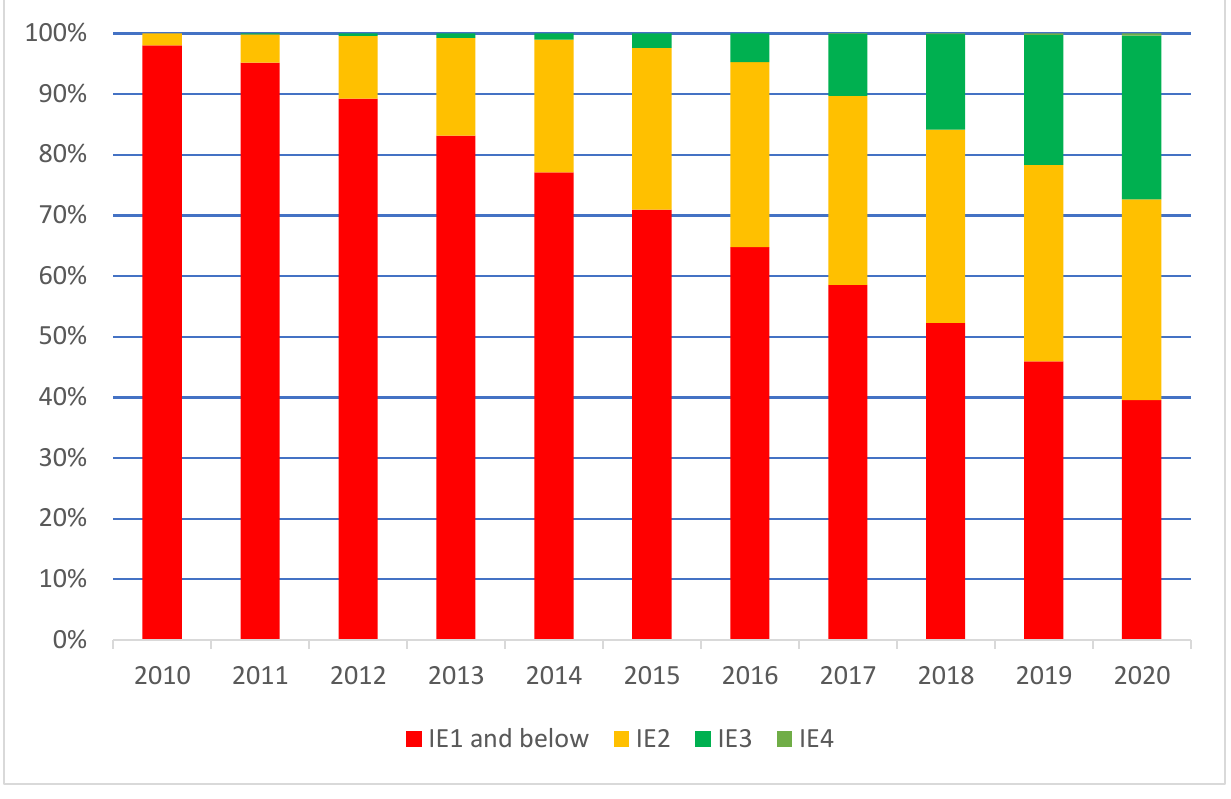
Figure 11. Estimation of EU-27 motor stock by efficiency class (Source: Authors).